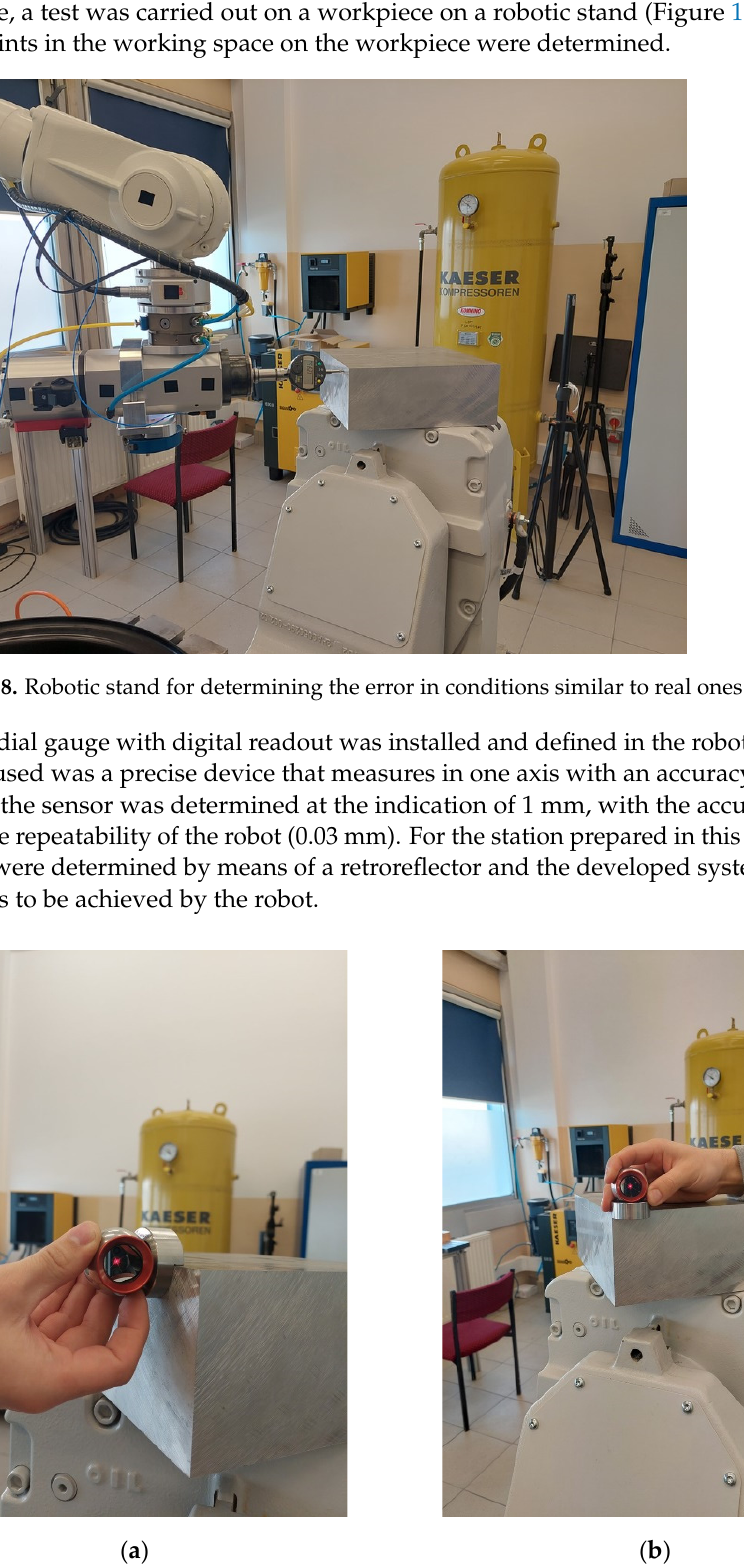
Figure 17. Error plots of the coordinates of points.